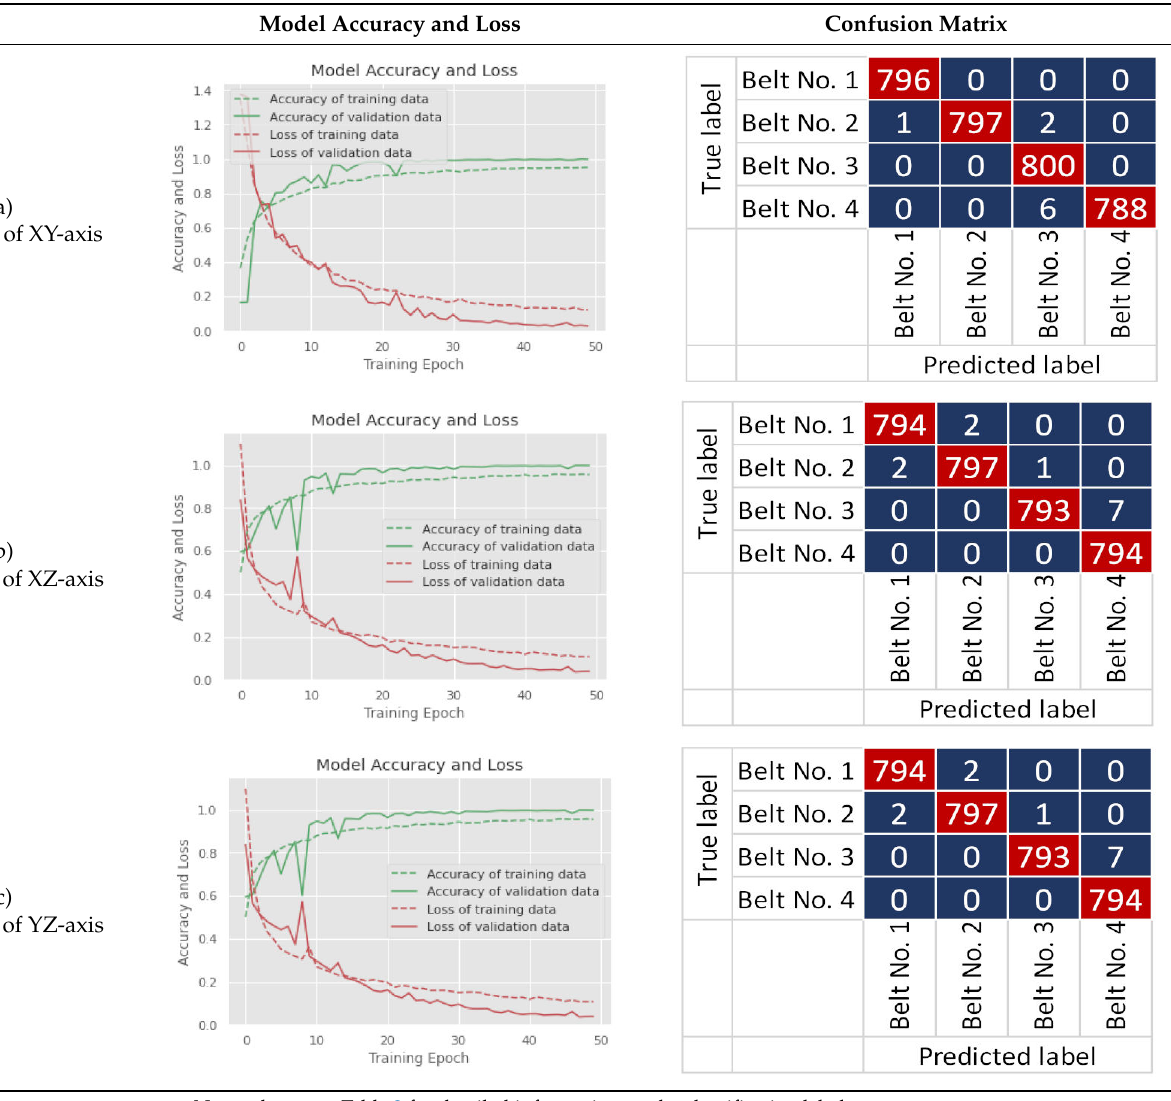
Table 6. Training curves and confusion matrix of double-axis force